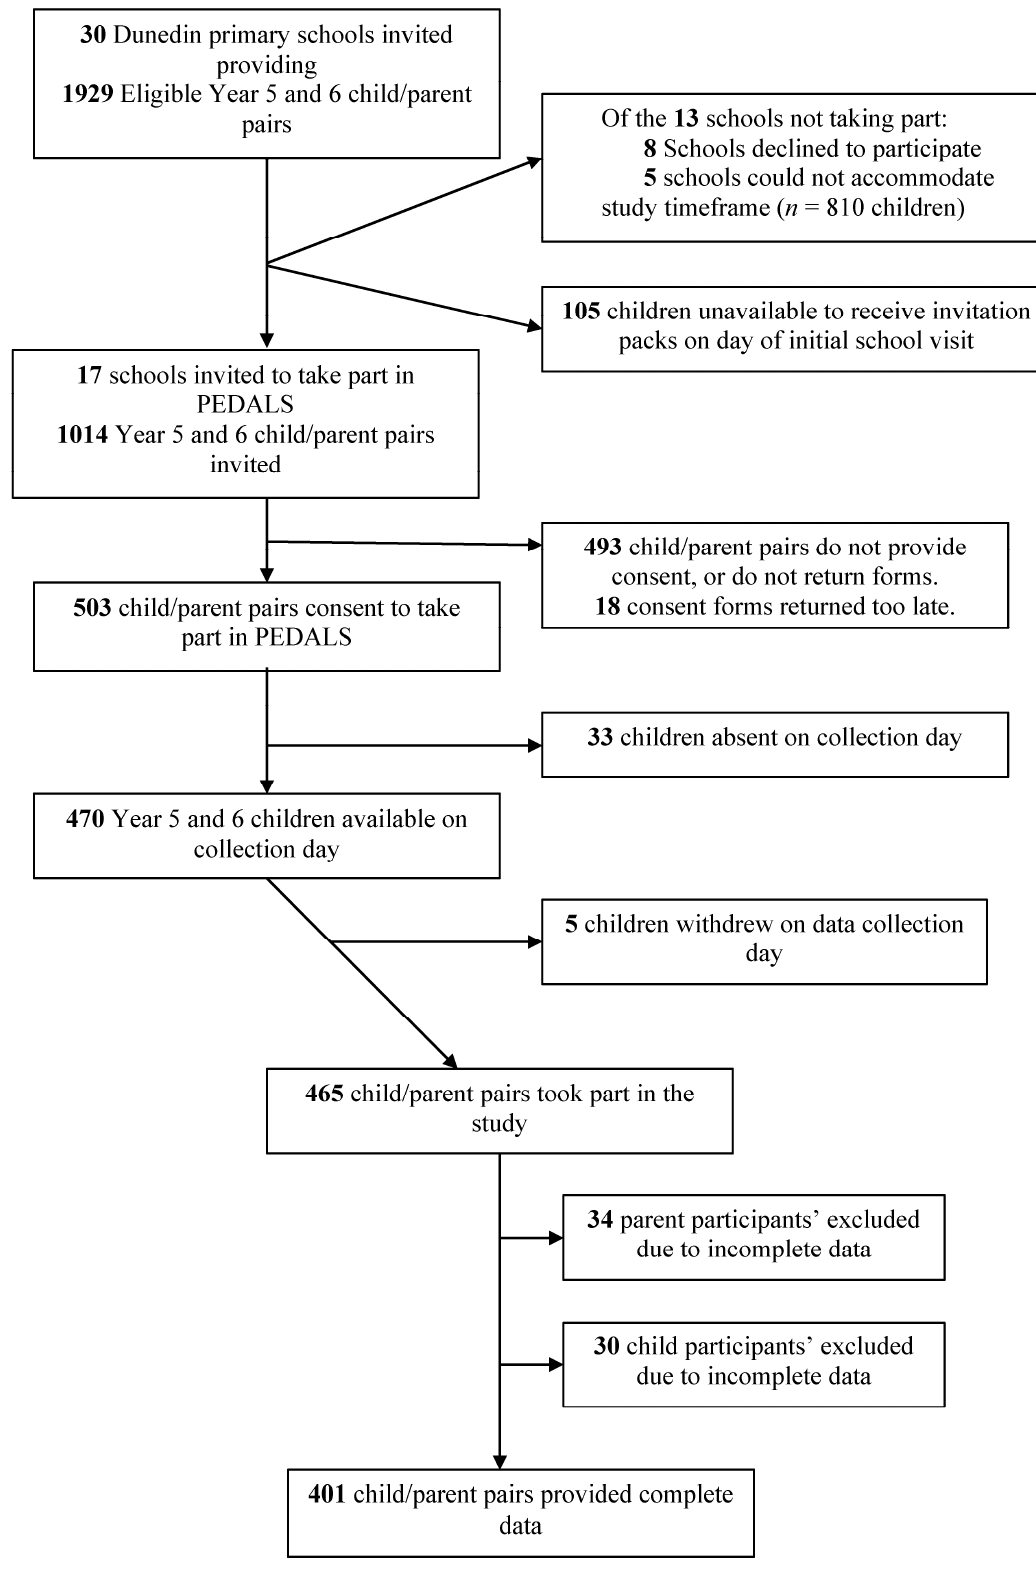
Figure 1. Recruitment flowchart for PEDALS.